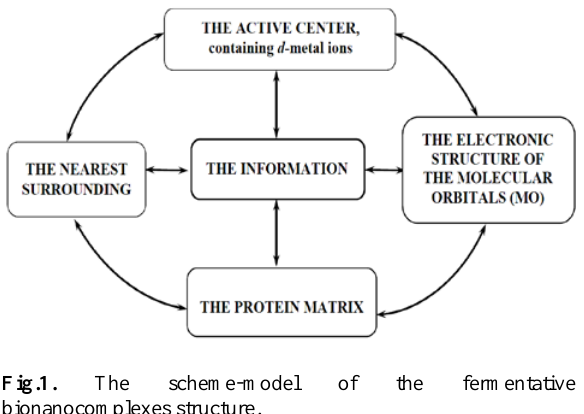
The scheme-model of the fermentative bionanocomplexes